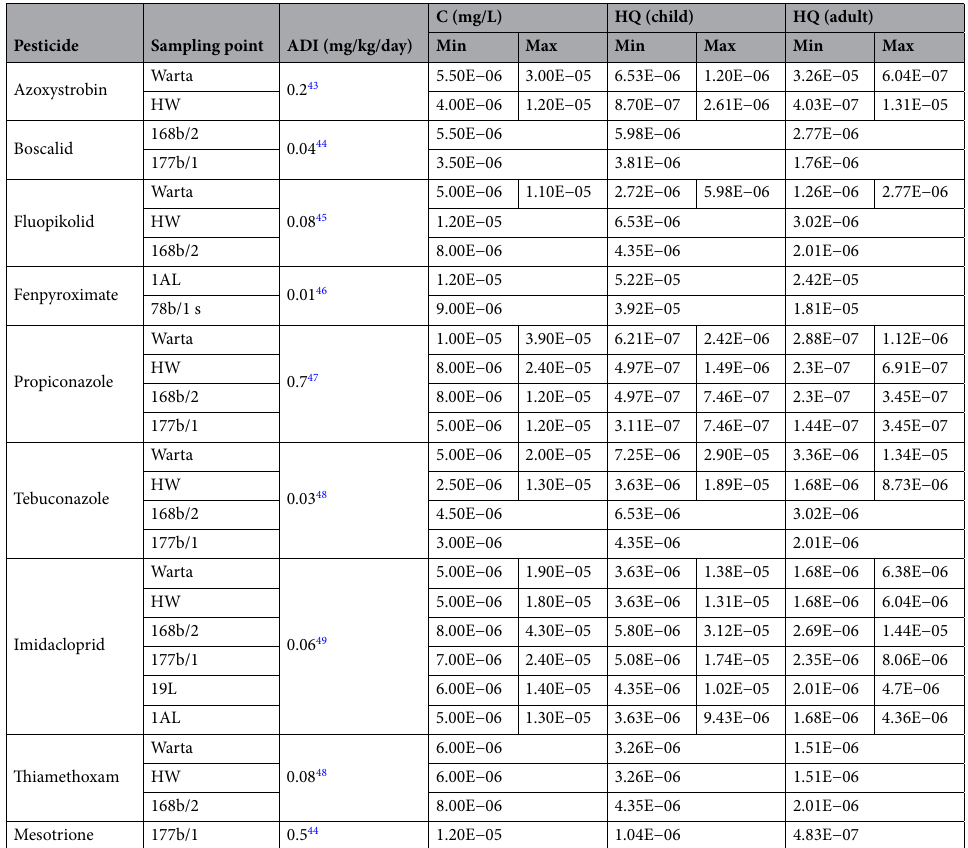
Table 5. HQ values indicating non-carcinogenic human risks. ADI acceptable daily intake; C the concentration of a pesticide in a river or RBF water, HQ hazard